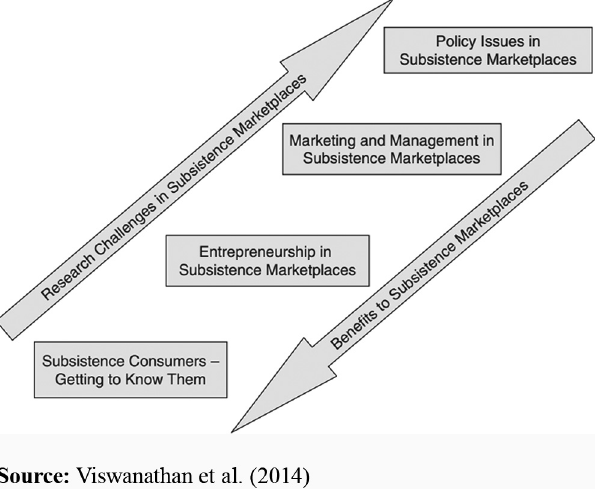
Figure 1. Subsistence marketplace